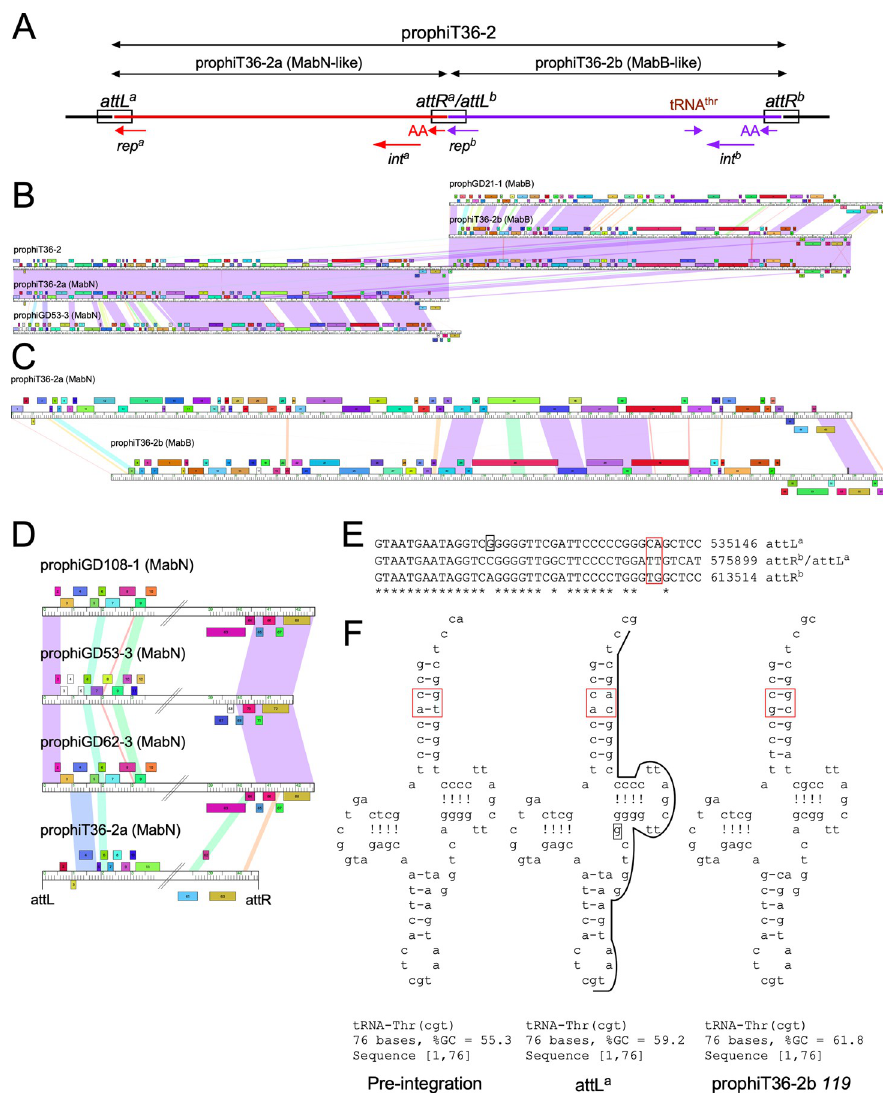
Fig 3. An unusual tandem prophage in M . abscessus T36. A . An overview of the proposed tandem prophage insertion, prophiT36-2a and b, in strain M . abscessus T36. ProphiT36-2a (red) is grouped into Cluster MabN, and prophiT36-2b (purple) is grouped into Cluster MabB. The putative attachment ( att ) sites are indicated as well as the repressor ( rep ) and integrase ( int ) genes. Both putative prophages use integration-dependent immunity systems in which the attP site is located within the repressor open reading frame of the phage, such that when integrated the 3’ end of the repressor gene coding for an ssrA -like degradation tag (shown as a short arrow with AA) is dissociated from the rest of the repressor gene ( rep ). B. Alignment of prophage genomes in the form of phamerator genome maps. Centrally positioned is the full phiT36-2 segment, and immediately above and below it are prophT36-2b and prophiT36-2a, respectively. At the top is the MabB prophage prophiGD21-1, and at the bottom is the MabN prophage prophiGD53-3 [30]. Genes are shown as colored boxes above and below each genome marker track, and pairwise nucleotide sequence similarity (from BLASTN) shown as spectrum colored shading between genomes with violet being the most similar; red indicates the least similarity above a threshold E value of 10 − 4 . C . Comparison of the prophiT36-2a and prophiT36-2b genomes, illustrating region of nucleotide similarity. D . Genome alignment of the left ends of Cluster MabN prophages. Note that the prophiT36-2a genome ends are not closely related to those of other MabN prophages, the integrases are not closely related, and this prophage likely uses a different attB site for integration. E . Sequences of the common core at the att sites. Segments of 40 bp corresponding to the common cores are shown for the att sites shown in panel A. The boxed nucleotides correspond to differences between the pre- integration tRNA (equivalent to MAB_t5010) and the tRNA at attL a . F . Predicted secondary structures of the pre- integration tRNA (t5010), the tRNA at attL a , and the tRNA gene ( 119 ) encoded by prophiT36-2b. Red boxed regions correspond to those in panel E. The line around the tRNA at attL a indicates the sequences contributed by prophiT36- 2a common